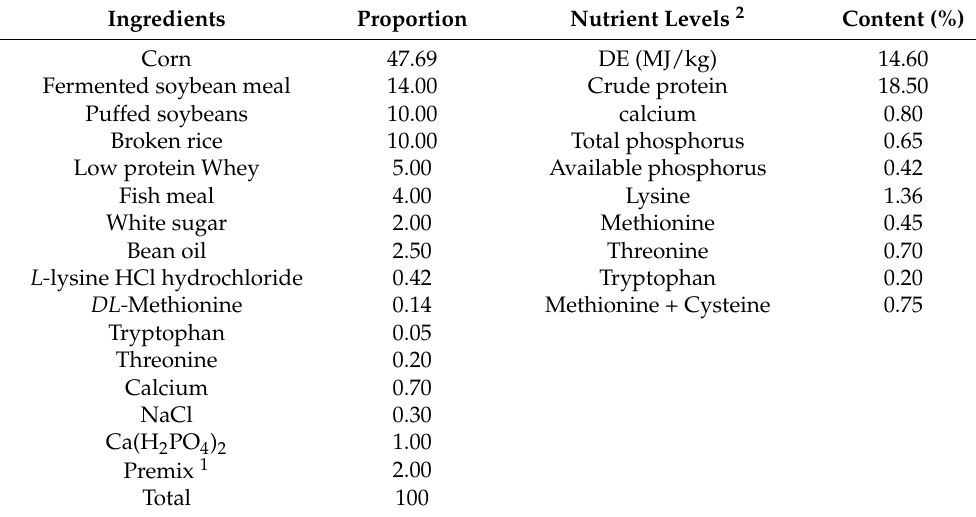
Table 1. Experimental diet composition and nutritional level (DM basis)